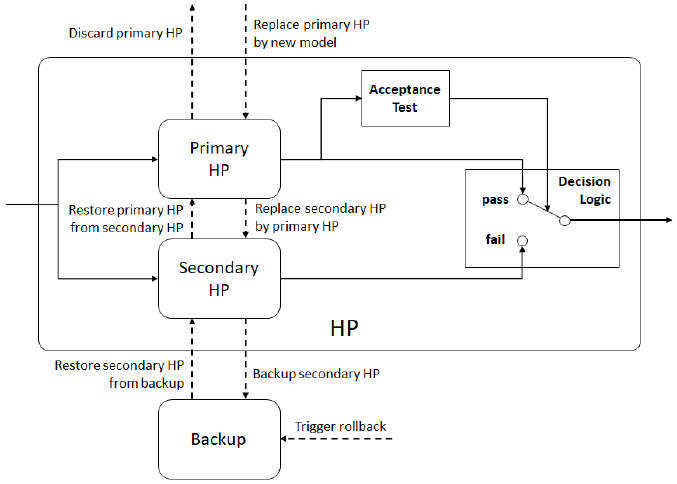
Figure 8. HP planner container implemented as a recovery block.